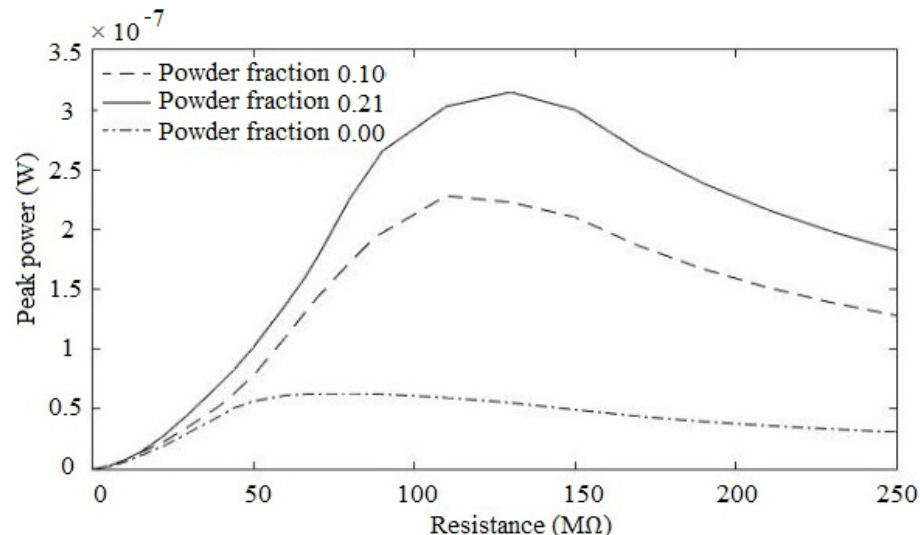
Figure 12. Peak power variation with the hair powder mass fraction.